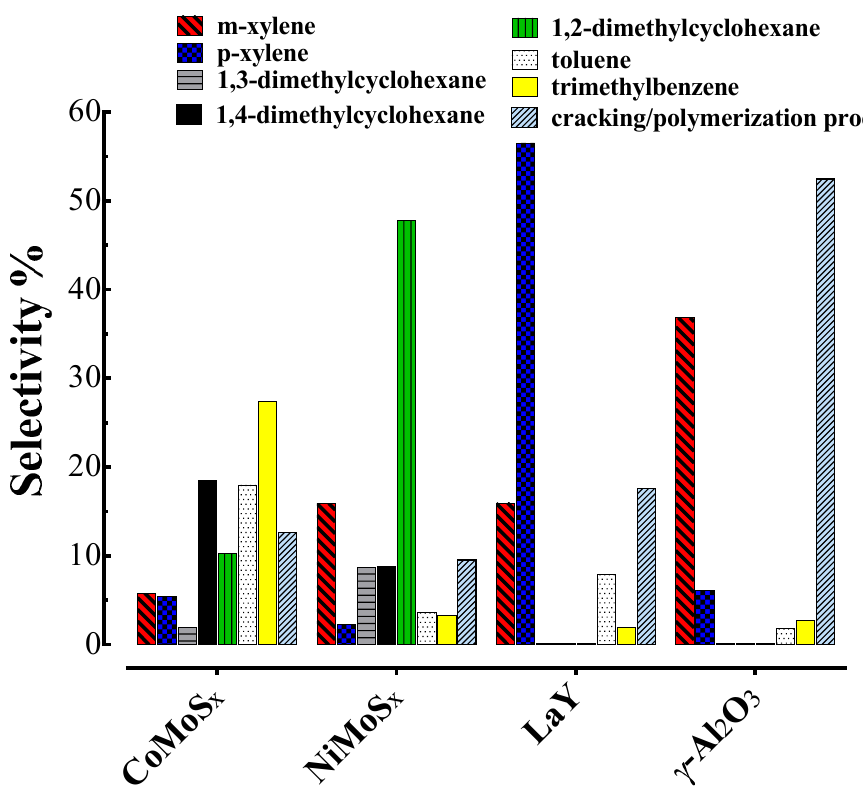
Figure 4. Product distribution in the o-xylene HDT process recorded at 24 h of t.o.s.